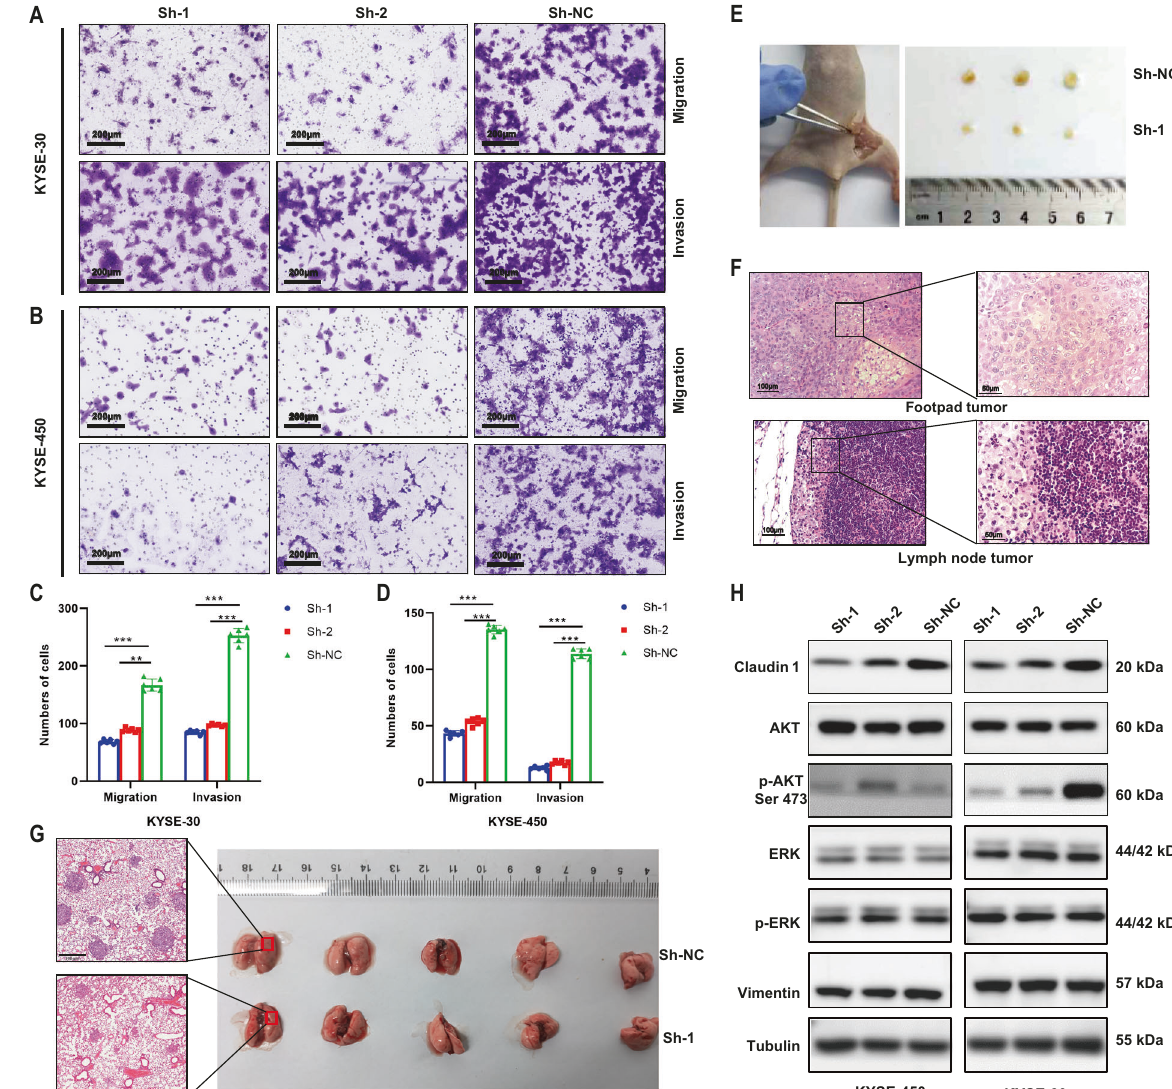
Fig. 3 Silence of PLEK2 inhibited metastasis of ESCC cells in vivo and vitro. A , B The migration and invasion ability of PLEK2 knockdown cells including KYSE-30 and KYSE-450; C , D Quali fi cation of number of cells that migrated through the membrane or invaded through the membrane; E Lymph node metastasis of KYSE-30 with PLEK2 stably knockdown; F Representative H&E images of popliteal lymph node; G Resected lung sections derived from mice injected via tail vein with KYSE-30 cells with or without PLEK2 stably knockdown; E Western blot analysis for the expression of Claudin-1, AKT, p-AKT (ser 473), ERK, p-ERK, and Vimentin. Tubulin was used as loading control.